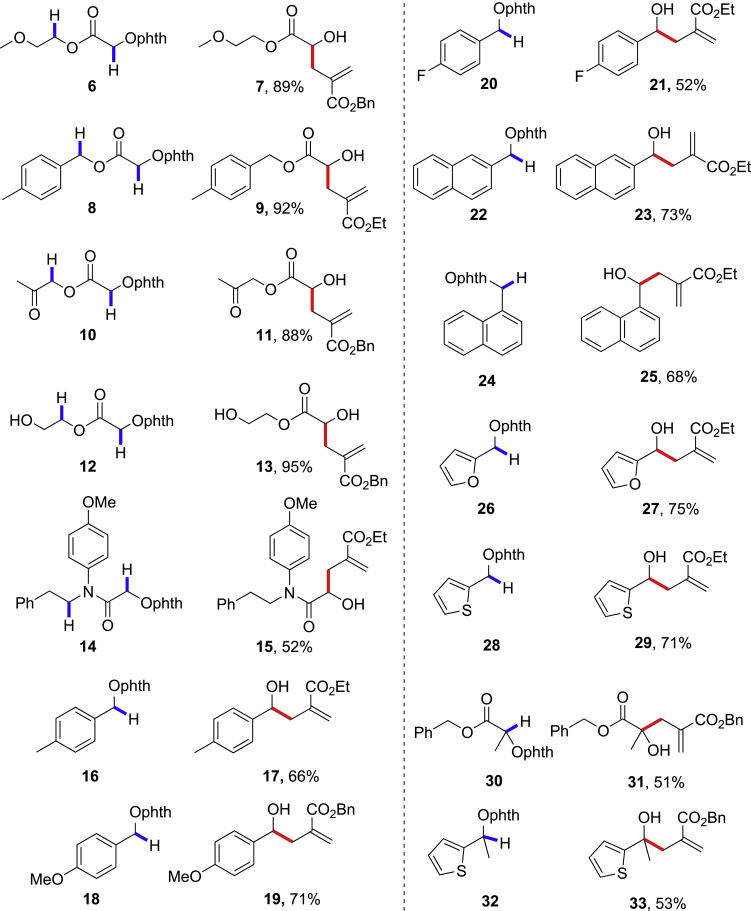
Substrate Scope of the 1,2-HAT ReactionsReaction condition is in entry 8 in Table 1, and isolated yields are reported.